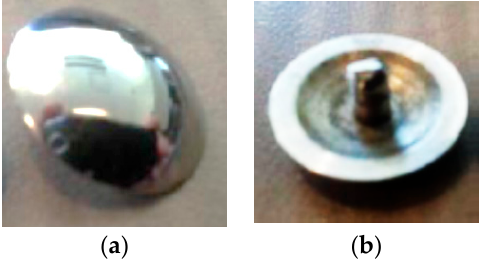
Figure 4. ( a ) Stainless steel electrode (electrode’s skin side); ( b ) Stainless steel electrode (electrode’s